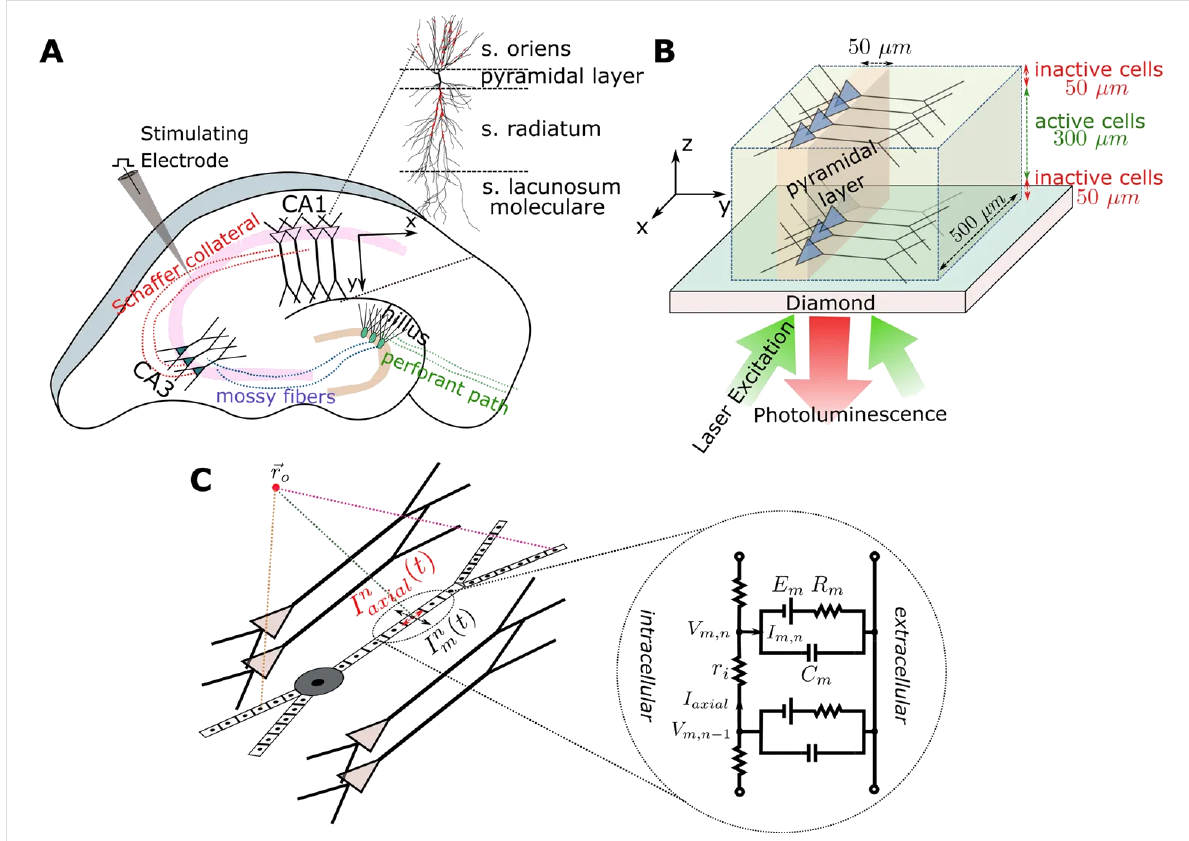
Figure 1: Diamond NV center mediated optomagnetic imaging of brain sample neural activity [72]. Image reproduced with permission from [72], an article licensed under a Creative Commons Attribution 4.0 International License, https://creativecommons.org/licenses/by/4.0/. (A) Trisynaptic path in hippocampus sample. Electrical stimulation of the Schaffer collaterals evokes CA1 area activity which is then recorded. (B) 500 × 500 × 300 µm 3 simulated CA1 subareas on top of the diamond surface, assuming up to 50 µm distance from the diamond makes neurons dysfunctional. Along x - and z -axis, the distribution of pyramidal cells is uniform, their soma locations being randomly jittered in a 50 µm wide band along the y -axis. Inverted microscope with a camera in place of a photodetector is used to detect the photoluminescence change in NV center layer emission due to neural magnetic fields. (C) Forward modeling scheme pyramidal cell multi-compartment